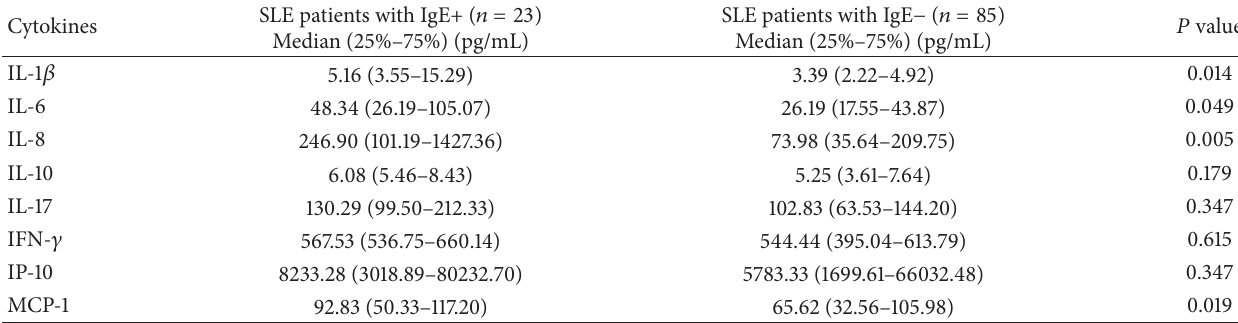
Table 4: Serum cytokine levels of SLE patients with IgE+ and with IgE − .